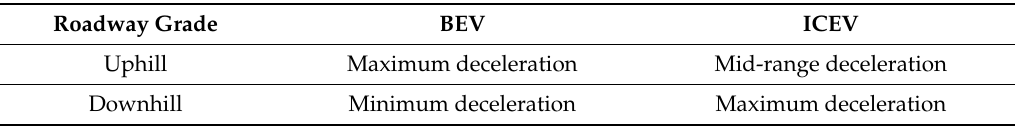
Table 1. Optimal solutions for BEVs and ICEVs Eco-CACC-I systems when the vehicle needs to decelerate to traverse a signalized